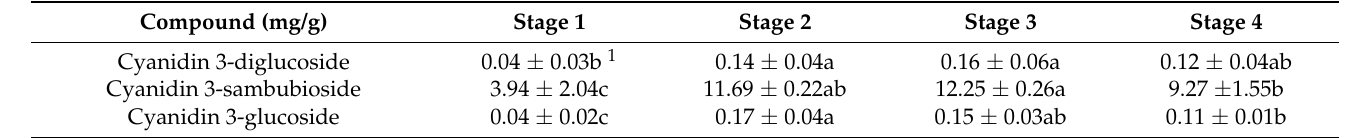
Table 4. HPLC analysis of anthocyanin in the different flowering stages of L . radiata . Compound (mg/g) Stage 1 Stage 2 Stage 3 Stage 4 Cyanidin 3-diglucoside 0.04 ± 0.03b 1 0.14 ± 0.04a Cyanidin